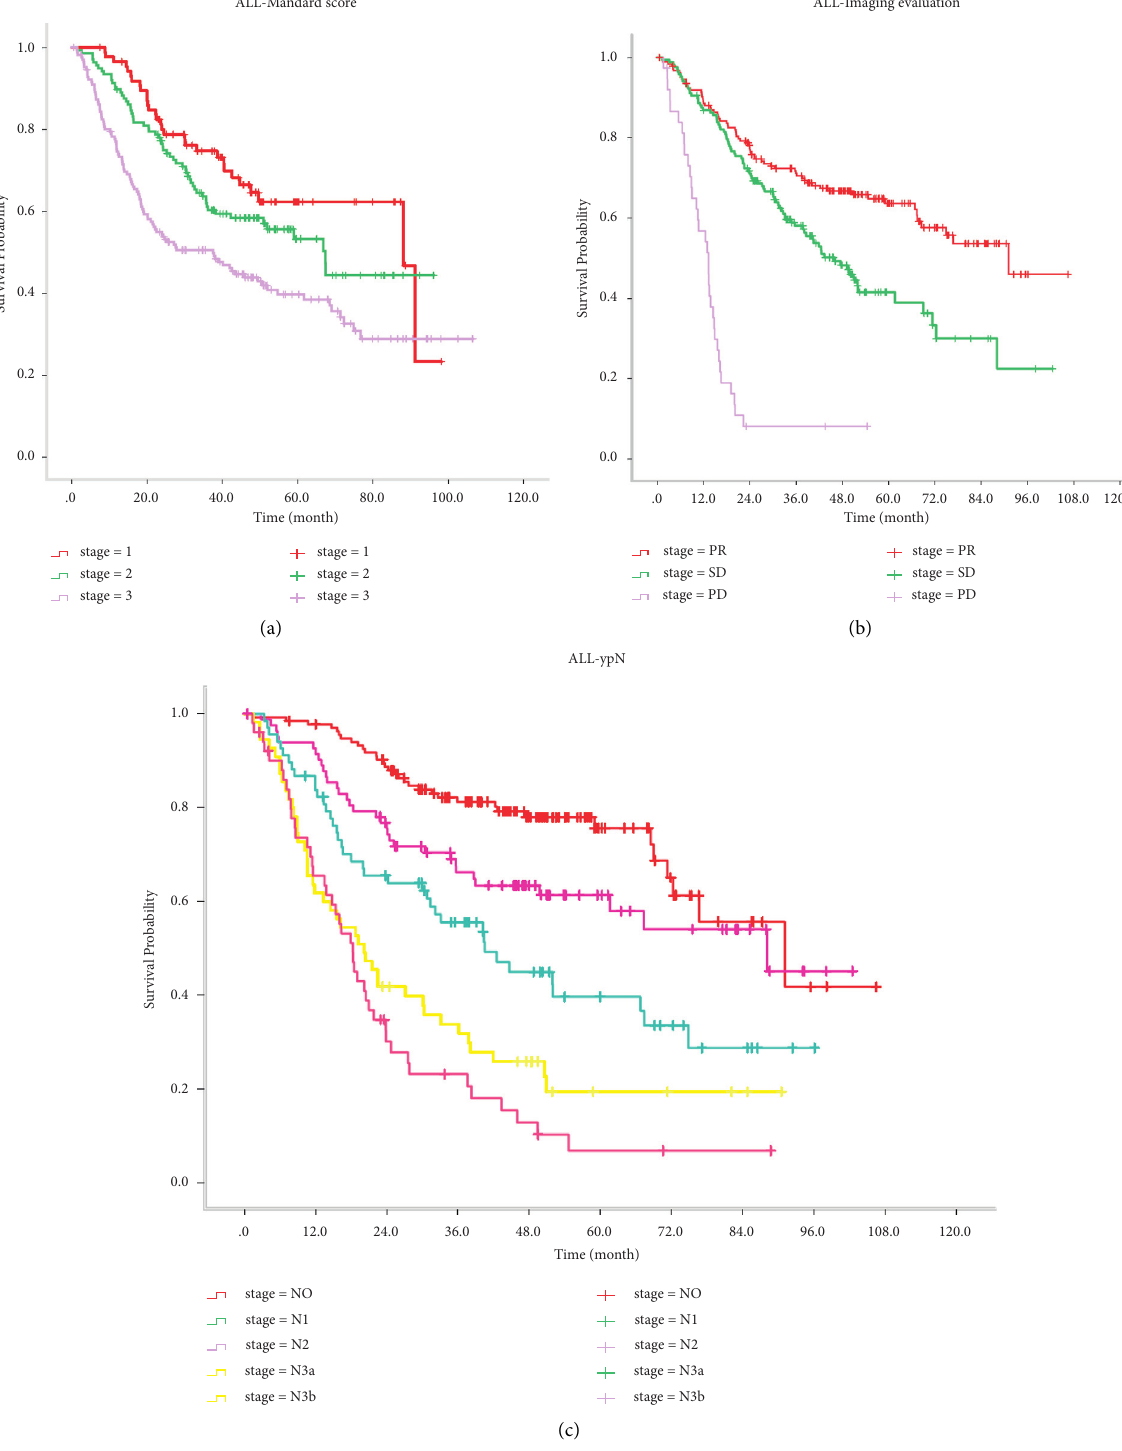
Figure 1: Kaplan–Meier survival analysis for all patients. (a) By the Mandard score group. (b) By the imaging evaluation group. (c) By the ypN